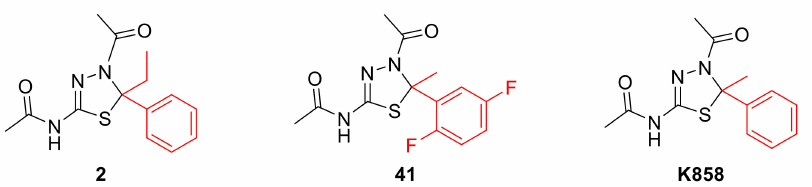
Figure 1. Chemical structures of Eg5 inhibitors 2 and 41 and their parent compound K858 . In red, chemical modifications in position 5 of the thiadiazoline core are